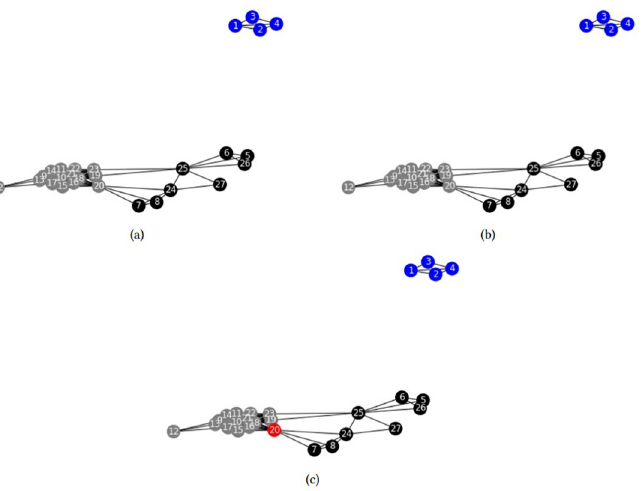
Fig 6. Zebra community structures. Community structures obtained by (a) F ∗ with parameters n c = 3, p = 2, (c) F 0 F ∗ Sh (cid:0) Mod